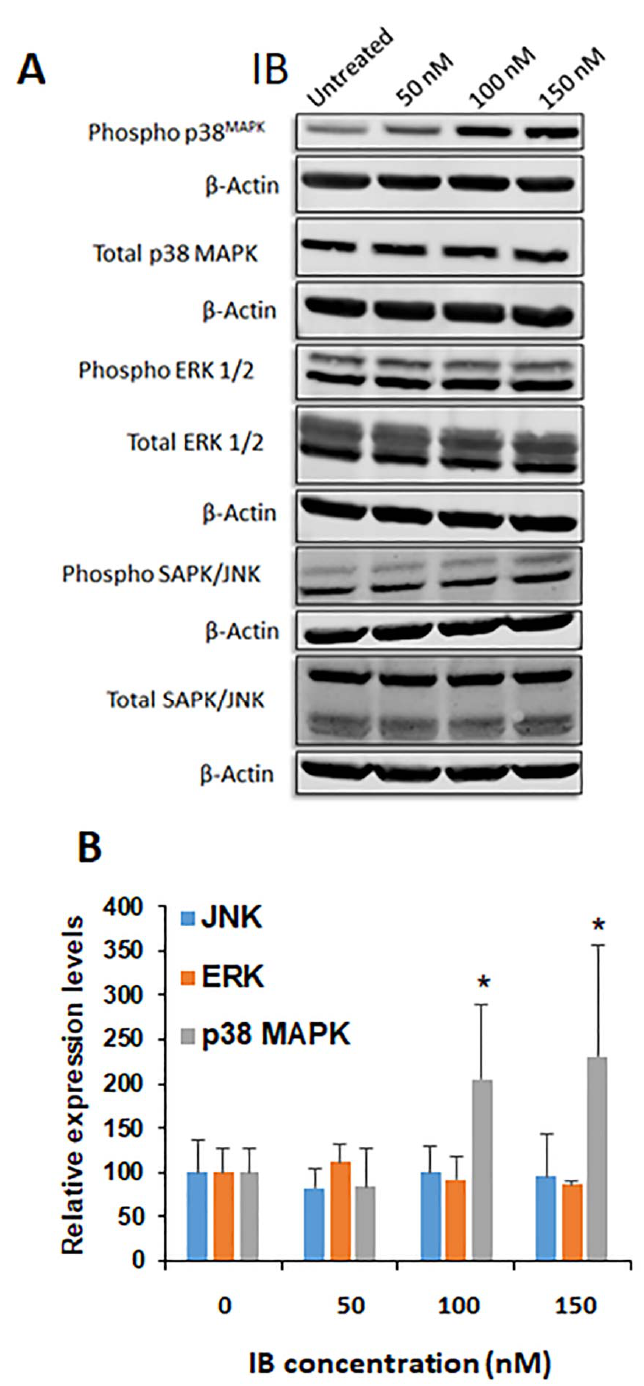
Figure 7. IB induces phosphorylation of p38 MAPK but not other MAPK family members. ( A ) MV4-11 cells were treated for 4 h with the indicated doses of IB. Western blot analyses were performed to compare phospho-signal to total signal for the following signaling pathway molecules: p38 MAPK, ERK1/2, SAPK/JNK. ( B ) Serial replicate MV4-11 cells treated the same as in panel A (4 h) were quantified and statistically analyzed to show the increase in p38 MAPK phosphorylation obtained at 50 nM, 100 nM, and 150 nM ( n = 6). As controls, both ERK1/2 ( n = 6) and SAPK/JNK ( n = 3) were also tested following IB treatment. The untreated control cells were normalized to 100 but the average error was used for 2-tailed T-test statistical analysis. p values calculated relative to untreated control for p38 MAPK phosphorylation were significant as indicated. * p <